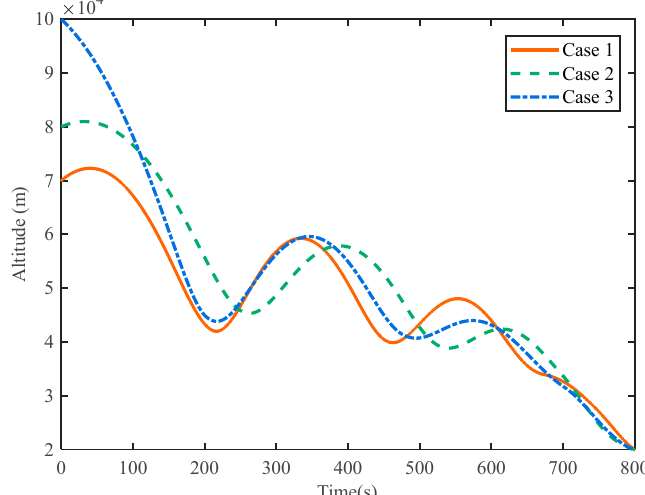
Figure 14. Time histories of the altitude.